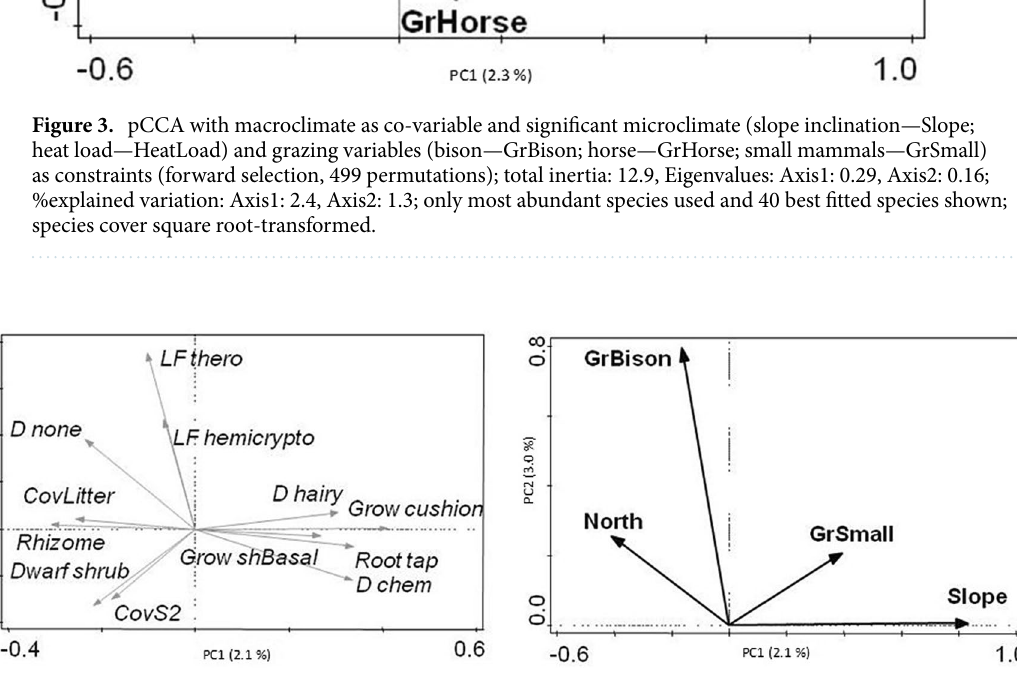
Figure 4. CWM-RDA (forward selection, 499 permutations) of overall data set, total variance: 7604, explained variance: 8.1%, Eigenvalues: Axis1: 0.04, Axis2: 0.01; %explained variation: Axis1: 5.4, Axis2: 1.7; ( a ) CWMs (only 50% most significant traits, which are also confirmed by direct univariate correlation of CWMs with environmental variables, are shown); ( b ) significant microclimate (slope inclination—Slope; northernness— North) and grazing variables (bison—GrBison); small mammals—GrSmall). See Appendix S2: Table S2_1 for abbreviations of plant